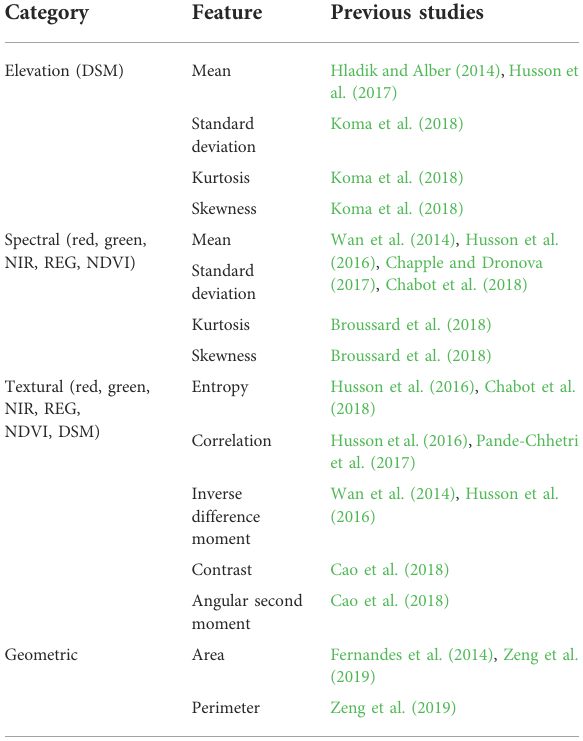
TABLE 2 Features used for classi fi cation and examples of their use in previous wetland classi fi cation studies.